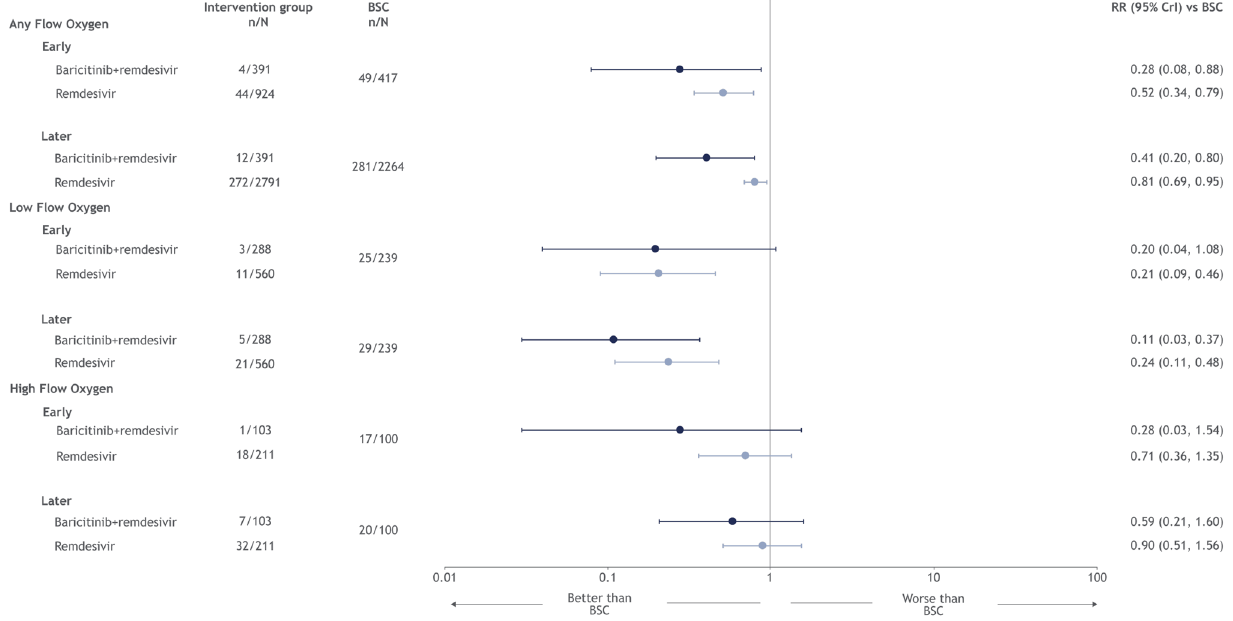
Figure 2. Forest plot for mortality endpoint, by type of non-invasive oxygen support.